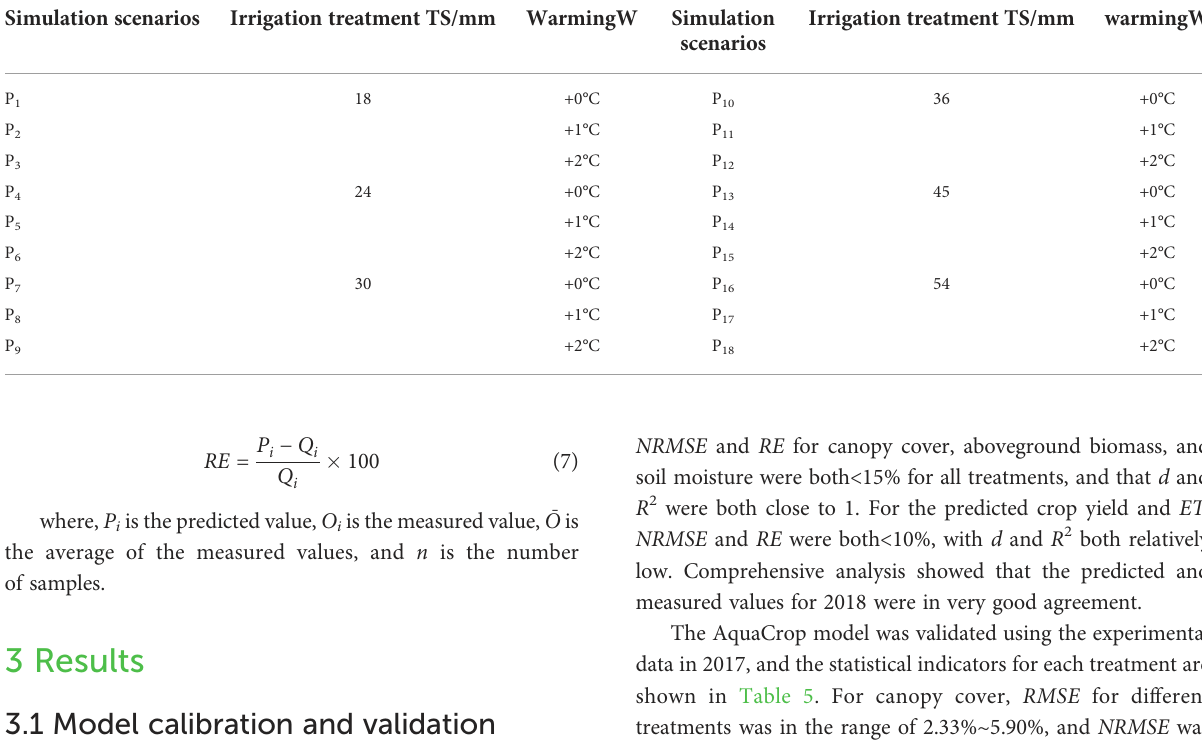
TABLE 4 Simulation